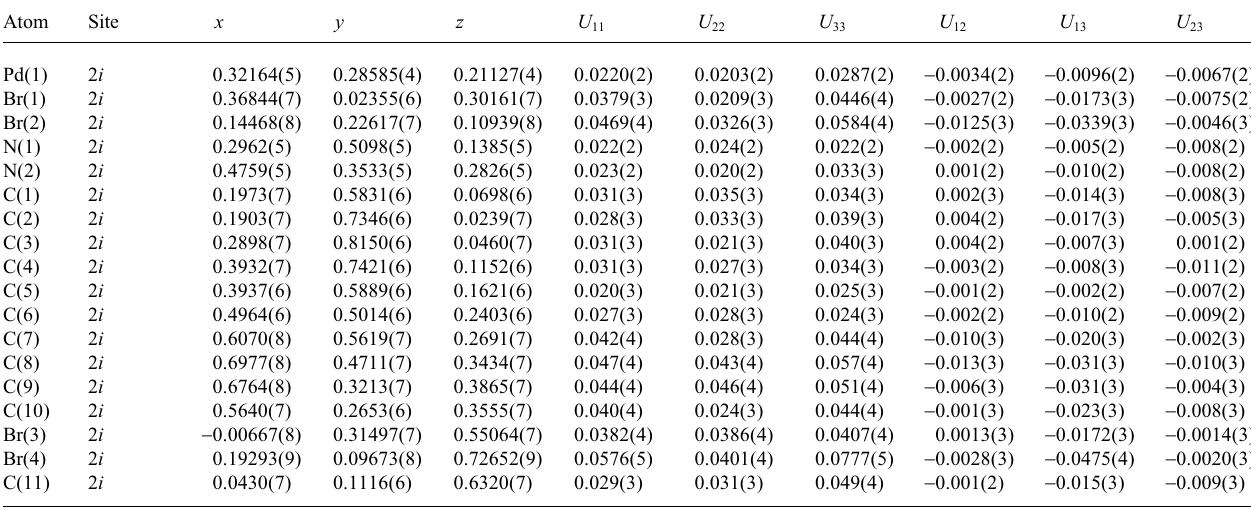
Table 3. Atomic coordinates and displacement parameters (in Å 2 )